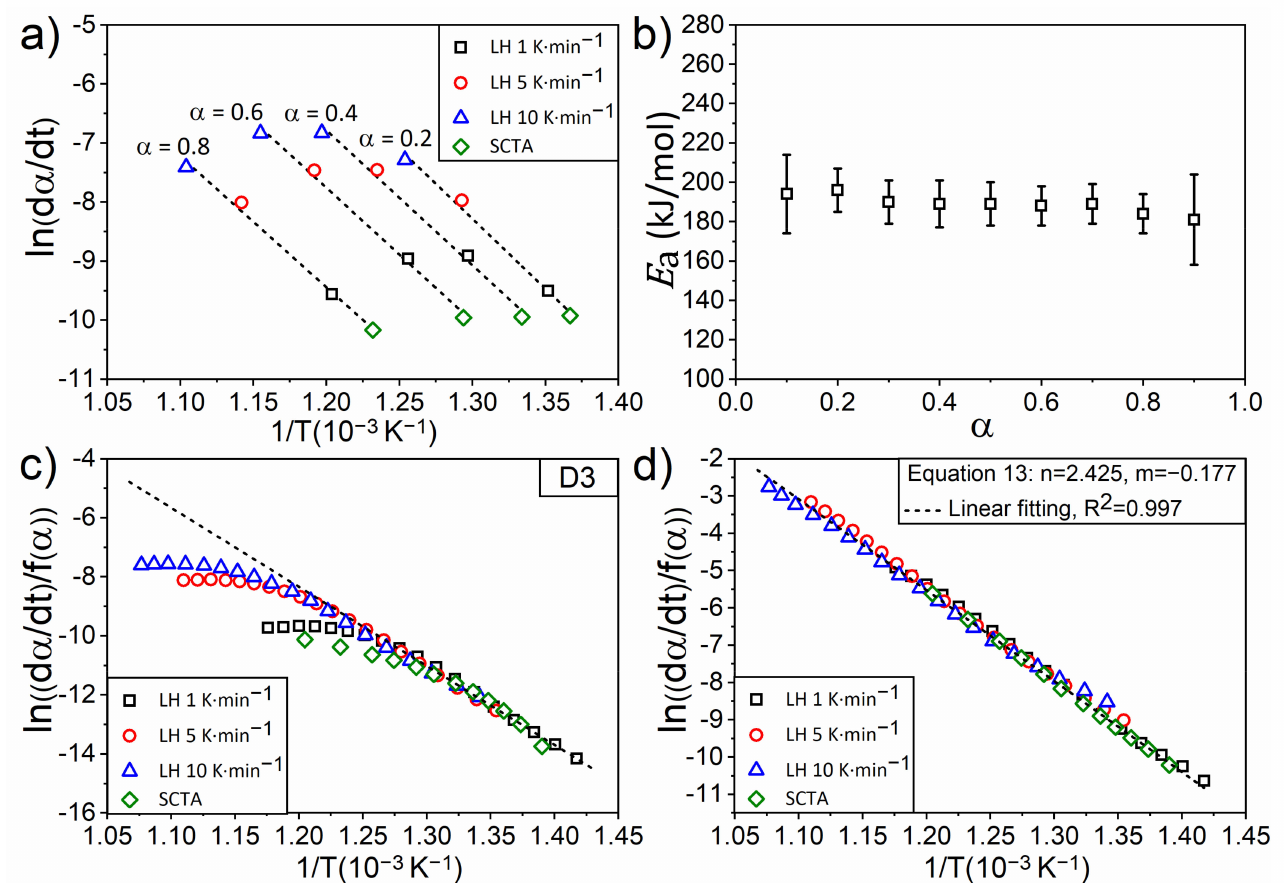
Figure 11. ( a ) ln ( d α / dt ) as a function of the inverse of temperature 1/ T for different values of α . ( b ) Values of the apparent activation energy as obtained by the Friedman isoconversional analysis (Figure 11a) as a function of α . ( c ) ln (( d α / dt ) / f ( α )) as a function of the inverse of temperature 1/ T for D3 and ( d ) for the modified Sestak–Berggren equation (Equation (13)) with the n and m parameters resulting from the optimization